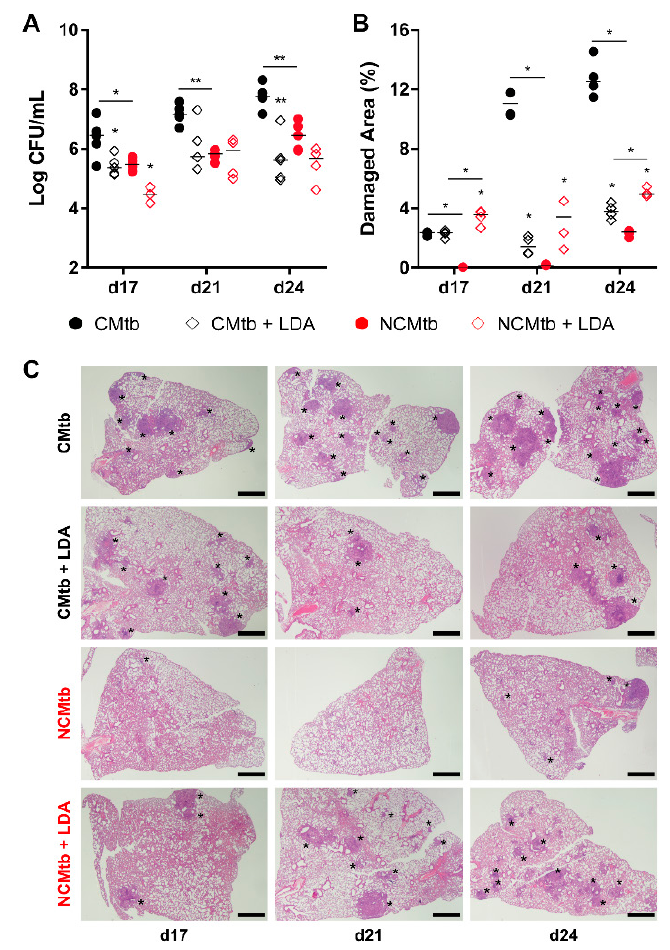
Figure 5. Protective effect of low dose aerosol (LDA) infection. ( A ) Progression of pulmonary BL, ( B ) lung damaged area ( C ) and evolution of the lesions. Each circle represents an animal ( A ) or a recut ( B ) and lines are medians. Asterisks indicate differences within the same batch; bar and asterisks indicate differences between batches. Mann–Whitney test (* p < 0.05, ** p < 0.01). Scale bars equal 1 mm and asterisks point lung lesions.